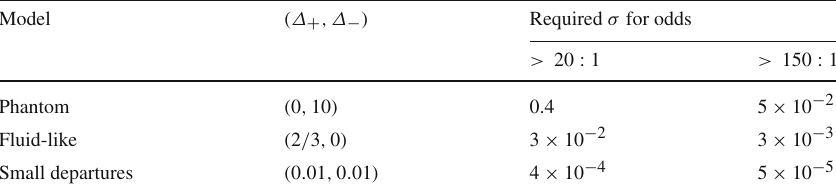
Table 2 Required precision σ of the value of w for future surveys in order to disfavor the three benchmark models against w = − 1 for two different strengths of